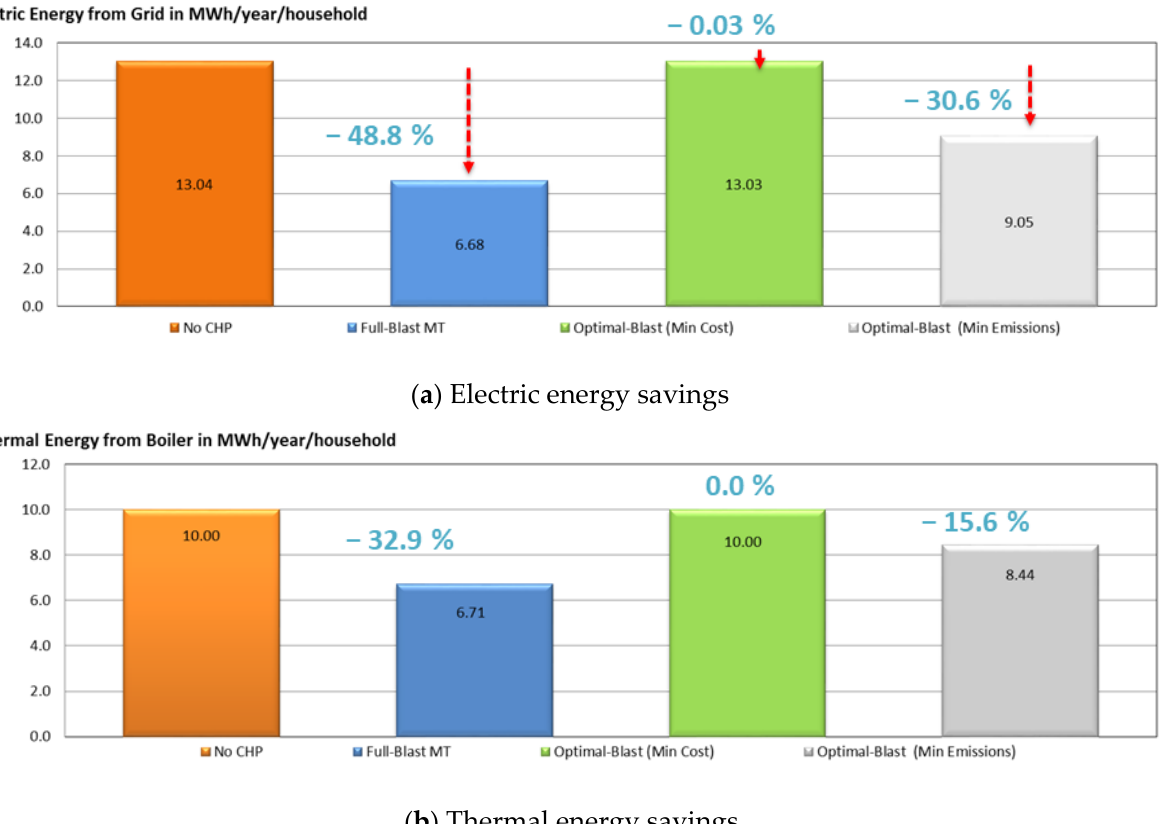
Figure 16. Annual energy savings (ABCs available).